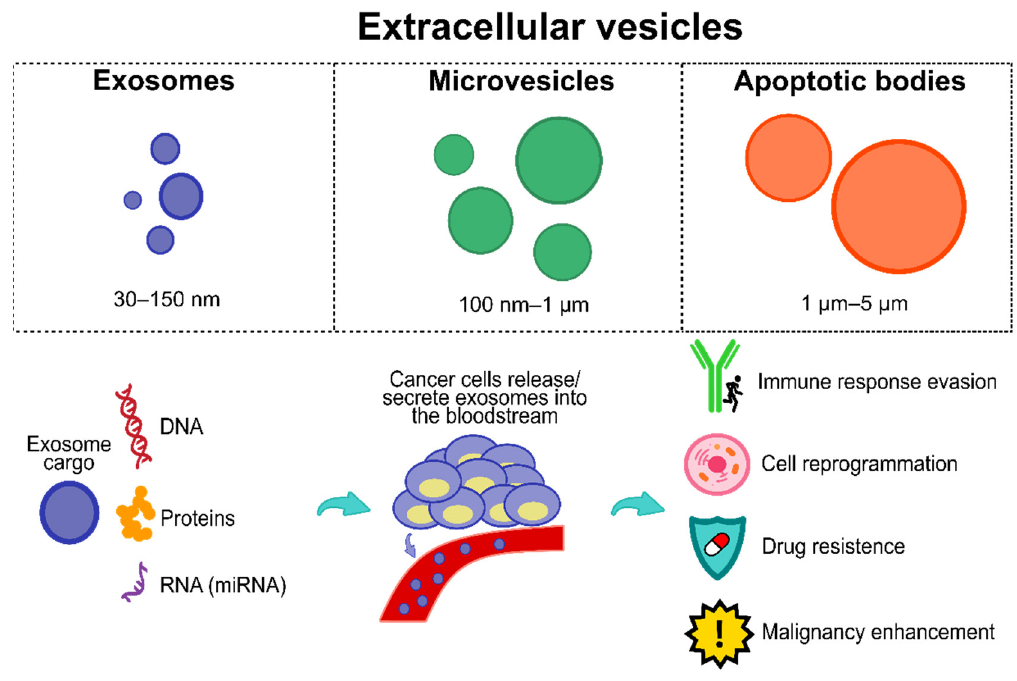
Figure 2. EVs and the importance of exosomes. Exosomes have a plethora of cargo (e.g., proteins, DNA, RNA, micro RNAs, among others). Cancer cells hijack exosomes and their cargo, releasing/secreting them into the bloodstream to obtain several features, including immune response evasion, cell reprogramming, drug resistance, and malignancy en- hancement.